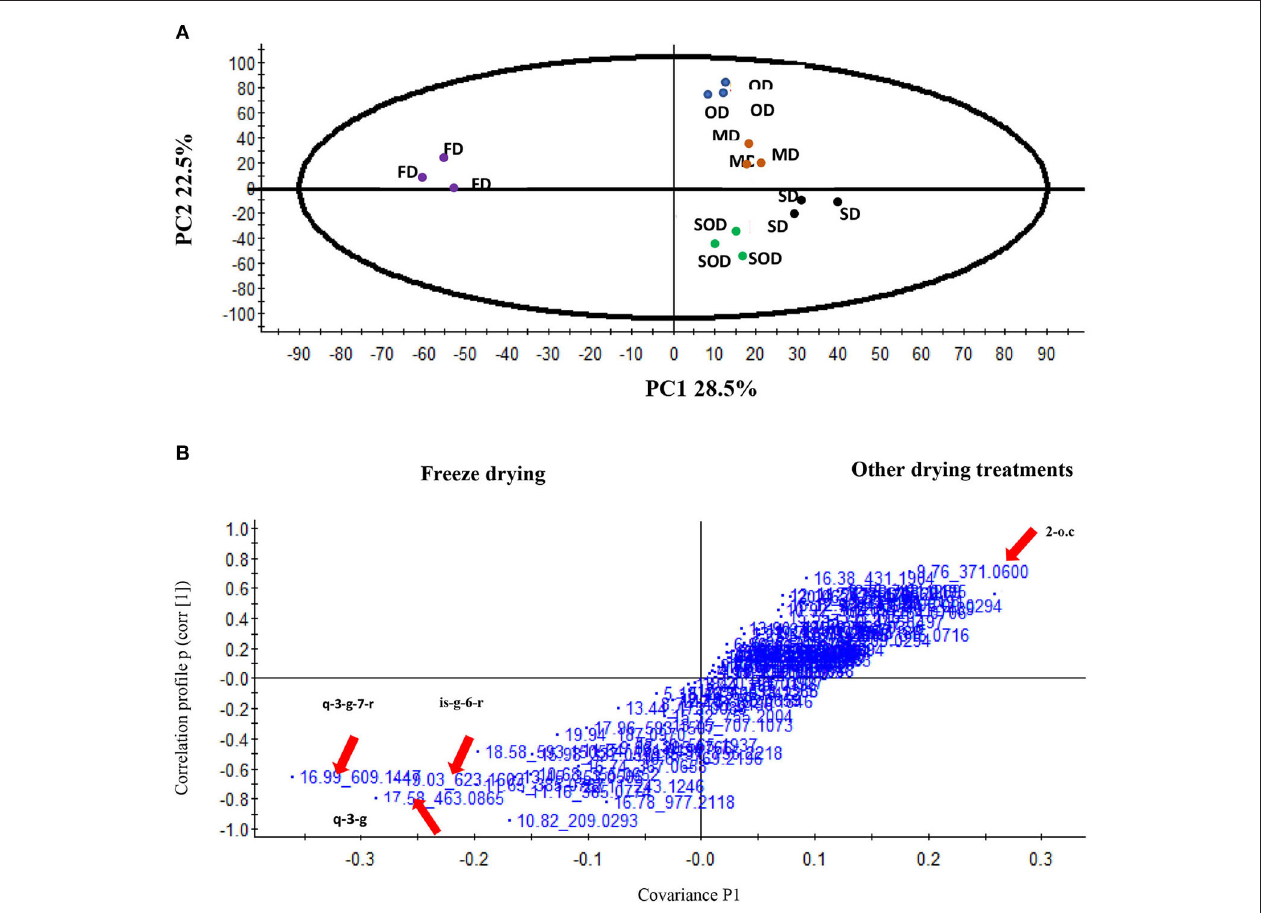
FIGURE 1 | (A) A score plot of principal component analysis (unsupervised) based on a Waters Synapt G2 Quadrupole time-of-flight (QTOF) mass spectrometer (MS), hyphenated to a Waters Aquity ultra-performance liquid chromatograph (UPLC) (UPLC–Q-TOF/MS) spectra (phenolic metabolic analysis) of the leaves of var. Butternut squash ( Cucurbita moschata) that underwent five different postharvest drying treatments. PC1 = 28.50% and PC2 = showing 22.5% of the leaves of three different pumpkin species. Each postharvest-drying treatment included three replicate samples. OD, oven drying; MD, microwave drying; SD, sun-drying; SOD, solar drying; FD, freeze-drying. (B) A score plot of orthogonal partial least squares discriminant analysis of UPLC–QTOF/MS spectra of the leaves of var. Butternut squash ( Cucurbita moschata) subjected to different postharvest drying treatments. Each sample set includes three replicates. m / z 371.05997, 2-O-caffeoylglucaric acid (2-o.c); m / z 609.1441 quercetin 3-galactoside 7-rhamnoside (q-3-g-7- r); m / z 463.08 quercetin 3-galactoside (q-3-g); m / z 623.16 isorhamnetin-3-galactoside- 6 ′′ -rhamnoside. isorhamnetin-3-galactoside-6 ′′ -rhamnoside (is-g-6-r).